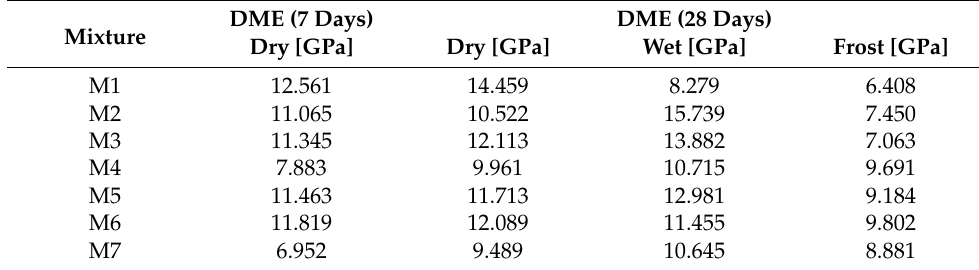
Table 7. Mean values of dynamic modulus of elasticity for all mixtures.